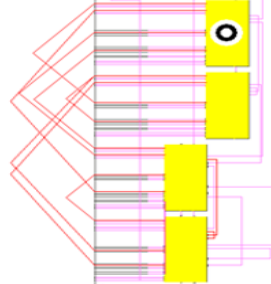
Figure 6. Implementation of a hard macro design of a single CLB.